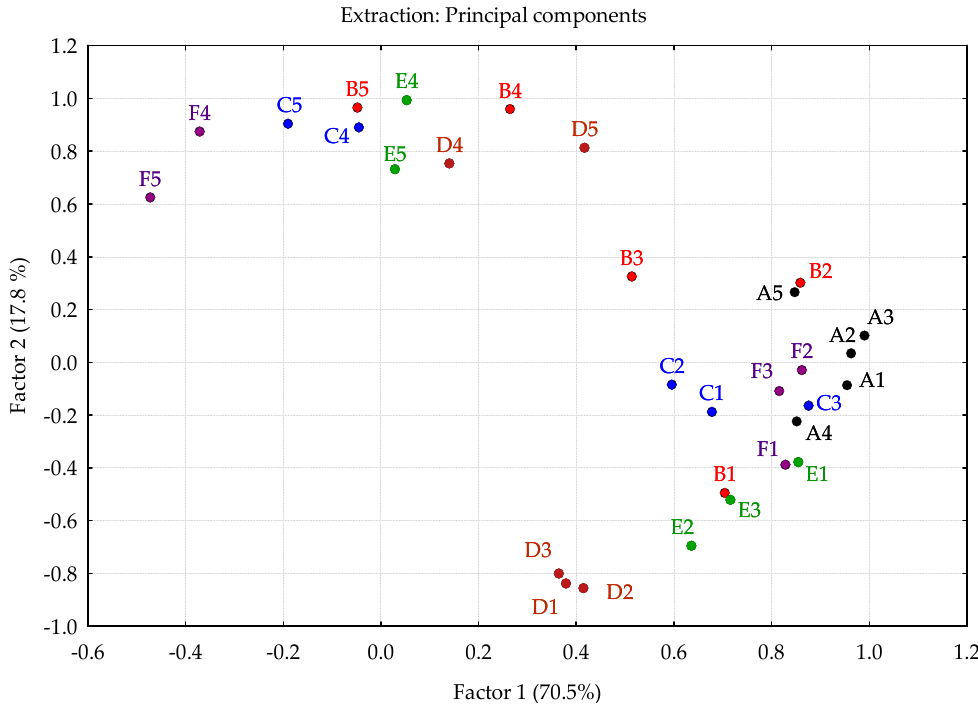
Figure 4. Principal component analysis bi-plot of cosmetic formulations. A–F indicate hand cream (HC), body oil (BO), shampoo (S), clay mask (CM), body exfoliating cream (BE), and a skin cleanser formulation (SC) respectively. 1–5 indicate control (without extract) grape pomace extract (GPE), pine wood extract (PWE), acacia flower extracts (AFE), and shiitake extract (SE), respectively.